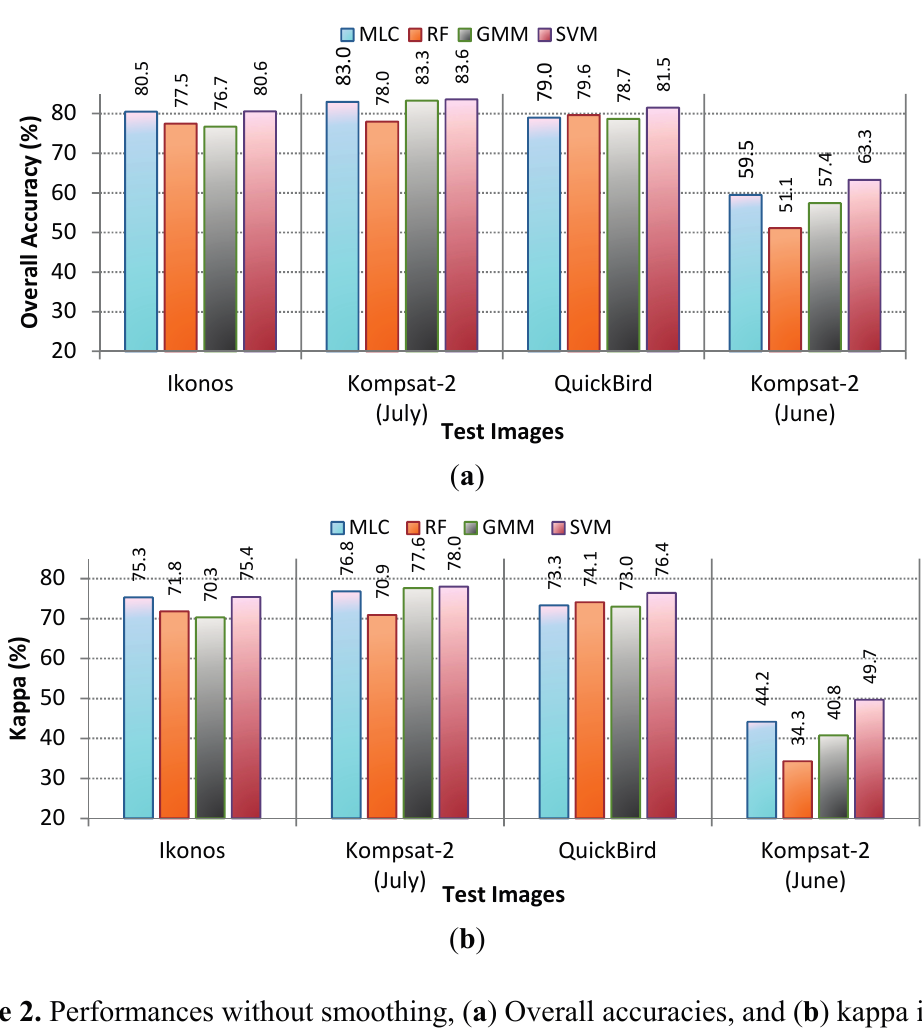
Figure 2. Performances without smoothing, ( a ) Overall accuracies, and ( b ) kappa indices.